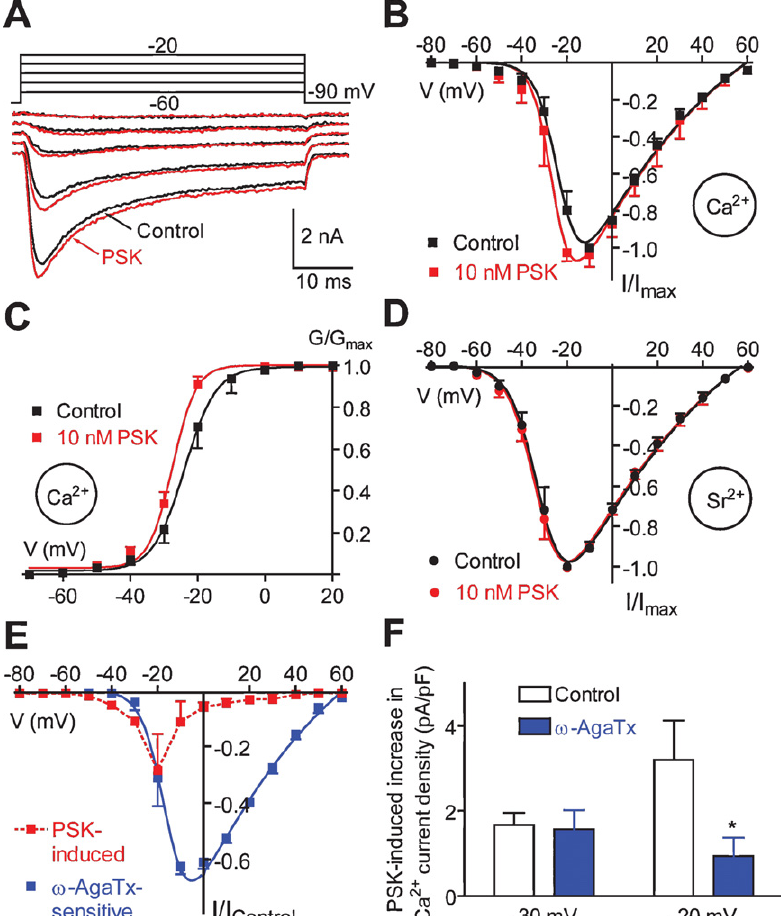
Figure 10. Effect of PSK on voltage-gated Ca 2 þ currents . ( A ) Families of Ca 2 þ currents before and 2minutes after application of 10nM PSK. Currents were activated by stepping from a holding potential of (cid:1) 90mV to voltages ranging from (cid:1) 60 to (cid:1) 20mV in 10mV increments. ( B , C ) I–V relationships (B) and G–V relationships (C) for Ca 2 þ peak currents before (Control) and 1minute after application of PSK. Data, means of 5–8 cells; bars, SEM. Curves were fitted to the data according to the GHK equation. ( D ) I–V relationships for Sr 2 þ peak currents before (Control) and 1minute after application of PSK. Data, means of five cells; bars, SEM. Curves were fitted to the data according to the GHK equation. ( E ) I–V relationships for the current produced by 10nM PSK (1minute) and the current blocked by 50nM v -AgaTx. Currents were normalized to the maximum of the I–V curve under control conditions. ( F ) Ca 2 þ current density produced by 10nM PSK (1minute) under control conditions and in the presence of 50nM v -AgaTx